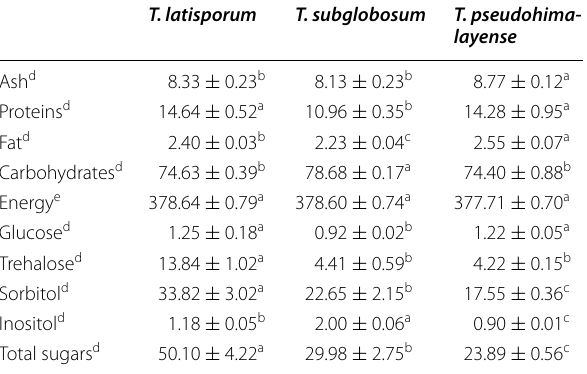
a,b,c In each row, the different letters represent significant differences between samples (p < 0.05); d % or g/100 g dw; e kcal/100